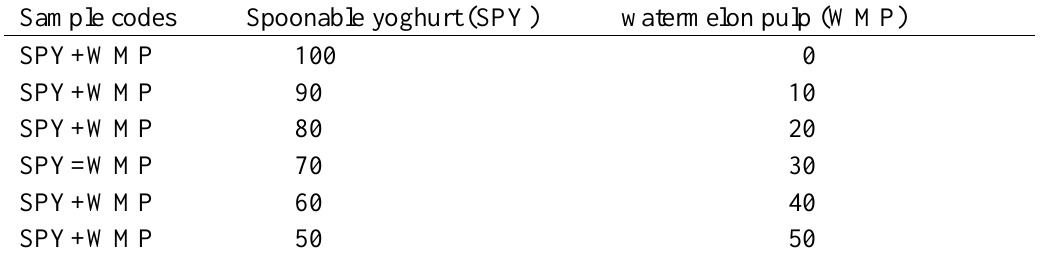
Table 1: Proportion for the production of spoonable yoghurt with watermelon pulp Sample